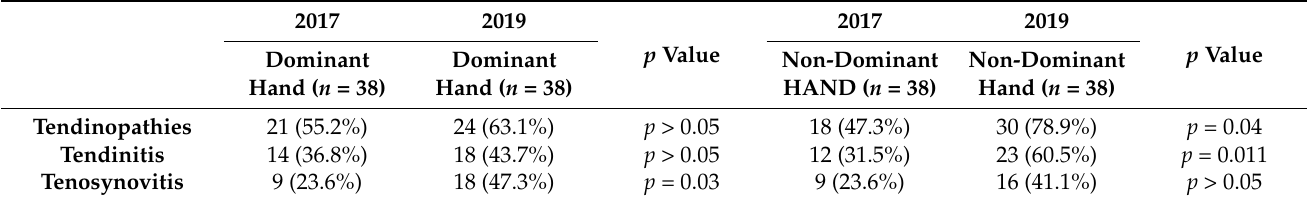
Figure 3. Symptom’s prevalence in dominant and non-dominant hand in 2017 and 2019. In both 2017 and 2019, the physical tests were positive in 10% of the subjects for both the dominant and the non-dominant hand. Subjects positive in 2019 were not the same subjects of 2017. UI revealed an overall increasing in the prevalence of tendinopathies (tendinitis and/or tenosynovitis) from 2017 to 2019. Considering all ultrasound compartments, the prevalence of tendinopathies in the dominant hand was 55.2% in 2017 and 63.1% in 2019 ( p > 0.05), while for the non-dominant hand it was 47.3% in 2017 and 78.9% in 2019 ( p = 0.04). The prevalence of tendinitis in the dominant hand was 36.8% in 2017 and 47.3% in 2019 ( p > 0.05), while for the non-dominant hand it was 31.5% in 2017 and 60.5% in 2019 ( p = 0.011). The prevalence of tenosynovitis in the dominant hand was 23.6% in 2017 and 47.3% in 2019 ( p = 0.03), while for the non-dominant hand it was 23.6% in 2017 and 41.1% in 2019 ( p > 0.05) (Table 3). Table 3. Prevalence of tendinopathies (tendonitis, tenosynovitis or both), isolated tendinitis, and isolated tenosynovitis in 2017 and 2019 .